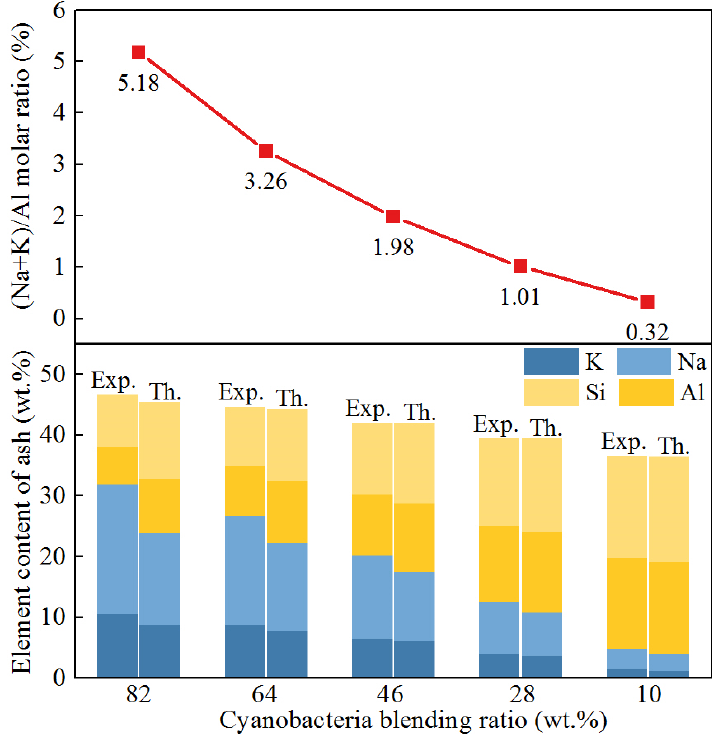
Figure 5. The (Na + K) / Al molar ratio and the comparison between the experimental and theoretical content ratio of alkali metals and mineral matters. Table 3. Kinetic parameters of the chemical looping co-gasification of cyanobacteria and coal obtained from the homogeneous reaction model (HRM) and the shrinking core model